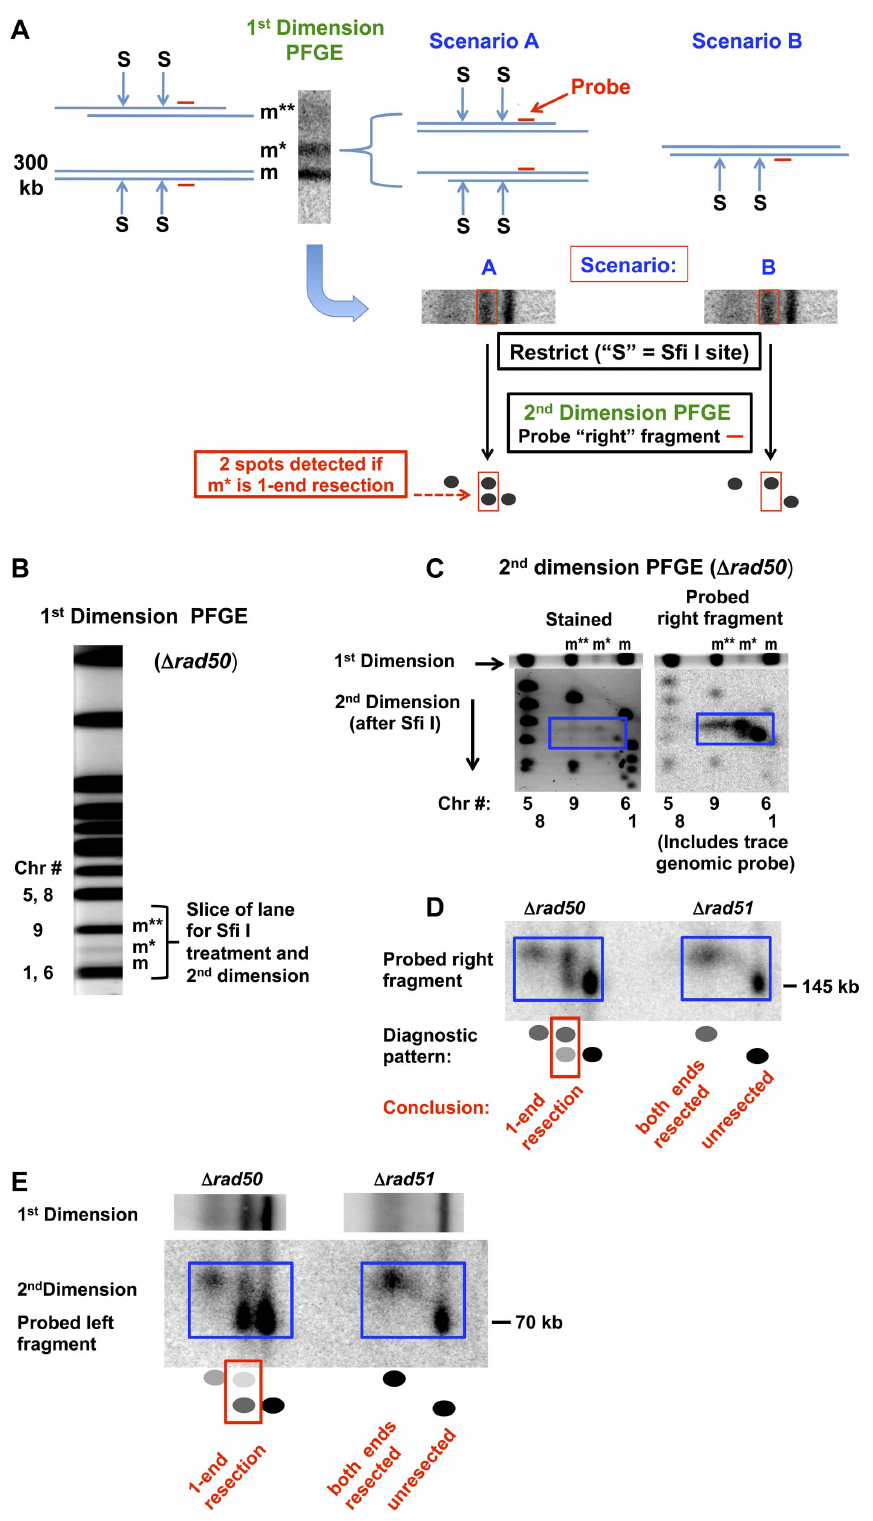
Figure 2. Detection of 1-end and 2-end resections at a DSB based on rare restriction cutter analysis of 1D PFGE-shifted molecules and subsequent 2D-PFGE. A. Diagram of approach to determine whether the m* and m** PFGE-shift bands of the broken Chr III are due to 1-end or 2-end resections. Cells are induced for I- Sce I, creating a single DSB in Chr III. The m band shown at the left of the gel-slice corresponds to a linear molecule with unresected DSB ends, and the m** band is proposed to be due to 2-end resections. The diagrammed molecules on the right of the gel slice represent two scenarios of resection that could account for the partial shift m* band. In scenario A molecules have extensive resection at only one or the other end while in scenario B both ends of the broken molecules have undergone only a small amount of resection. Diagrammed in the